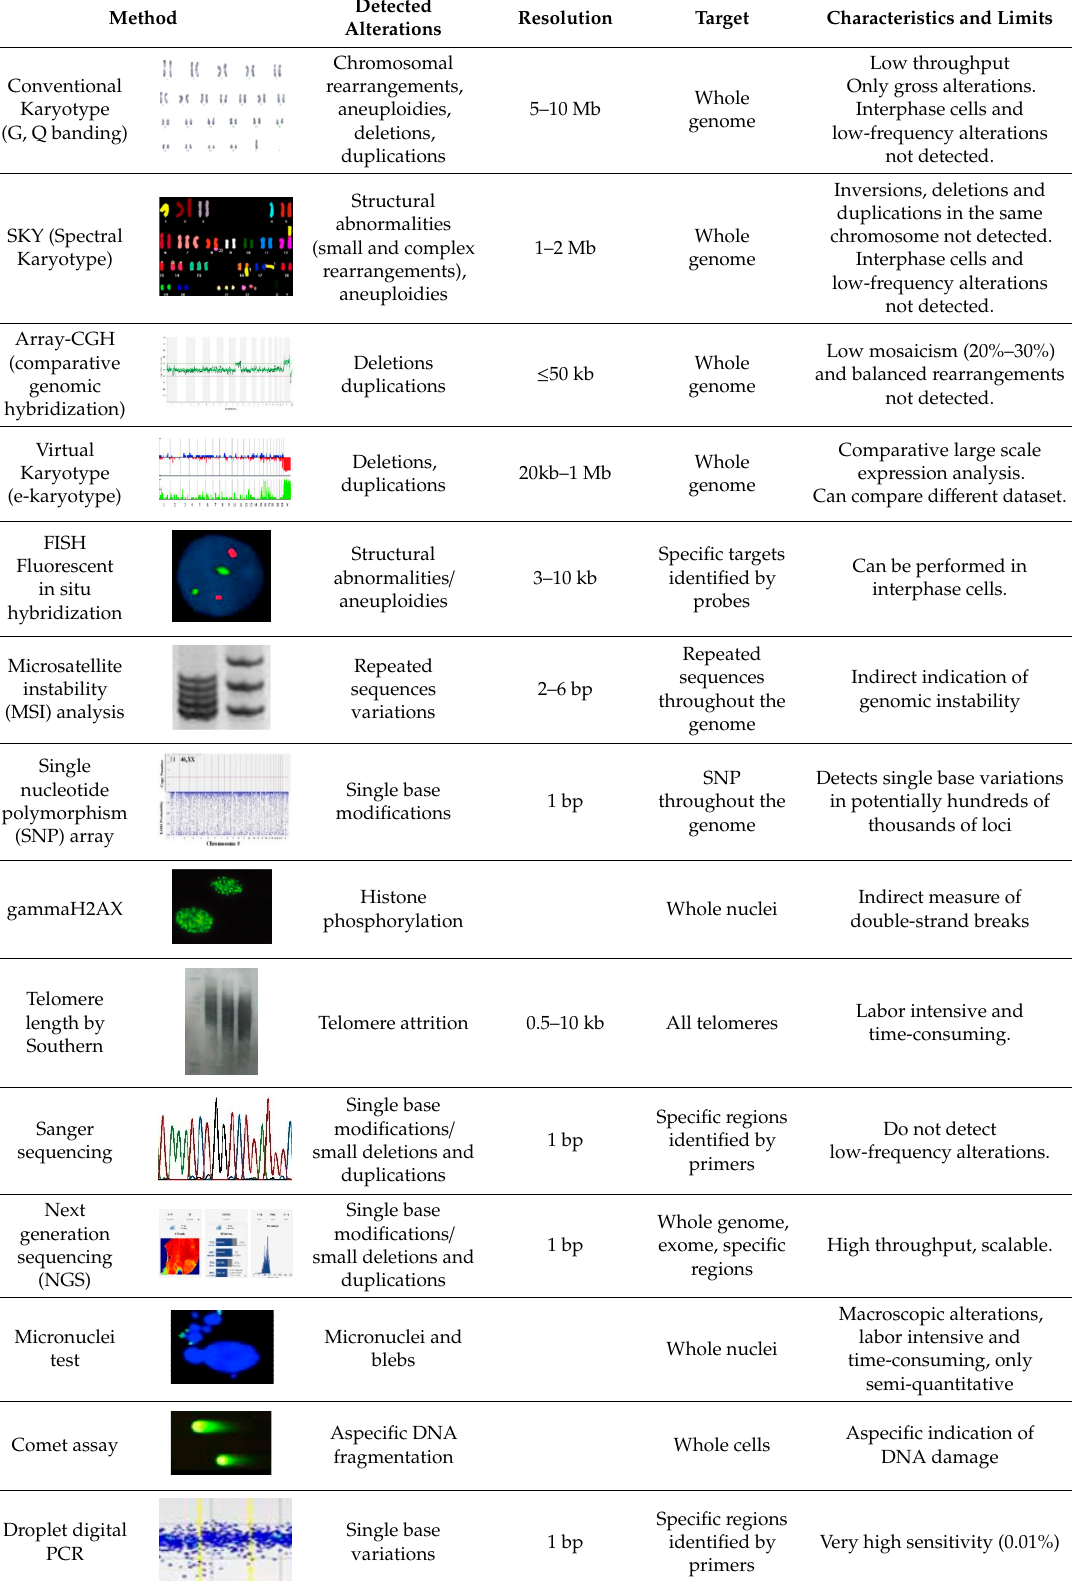
Table 1. Techniques to assess genetic damage. Methods are listed based on their level of resolution.